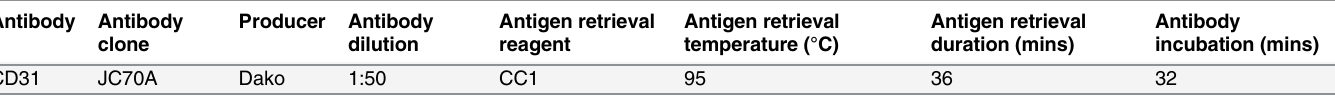
Table 2. Antibody and staining regime used in CD31 immunohistochemical staining. Antibody Antibody